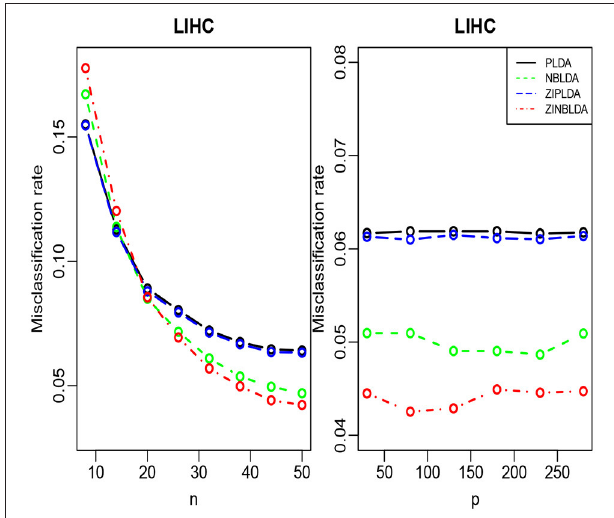
FIGURE 9 | The misclassification rates of the four classifiers for the LIHC